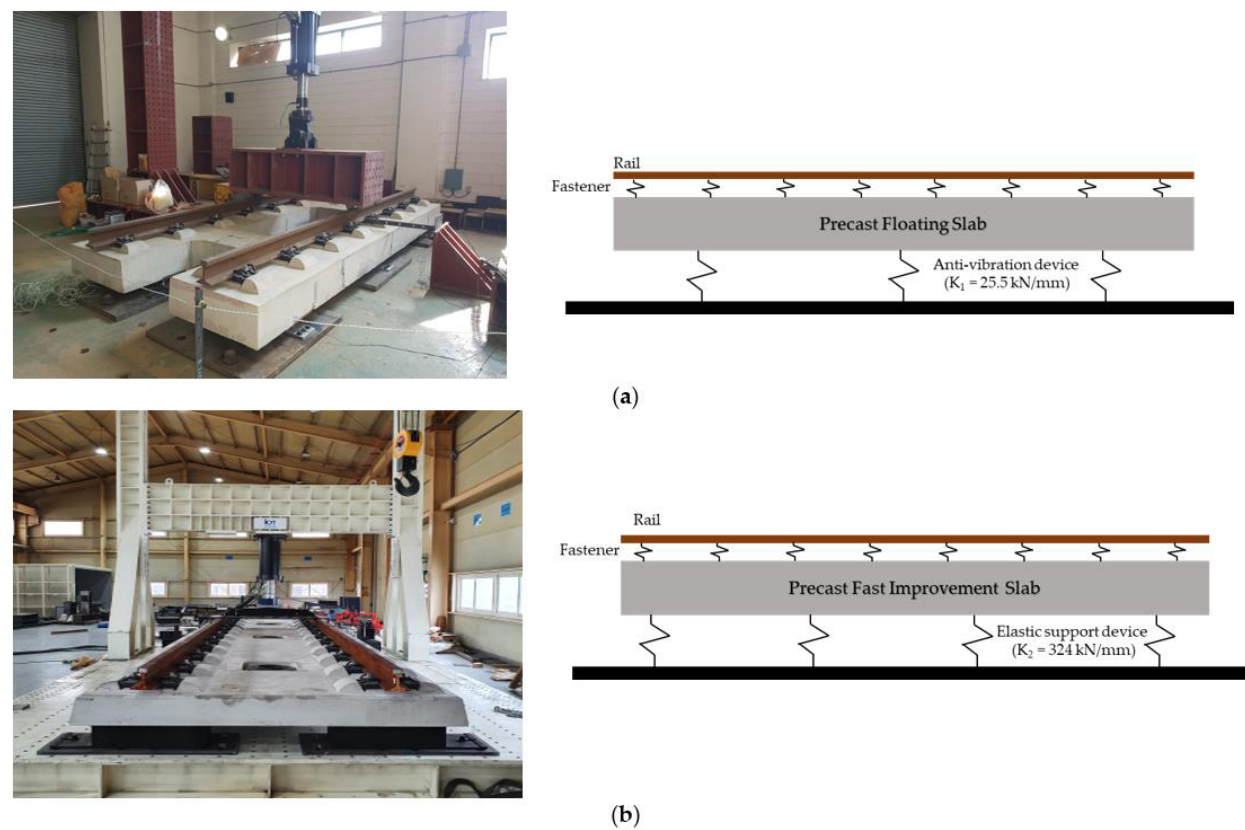
Figure 2. Precast slab track systems: ( a ) Type I: Precast Floating Slab Track, ( b ) Type II: Precast-Fast Improvement slab Track.